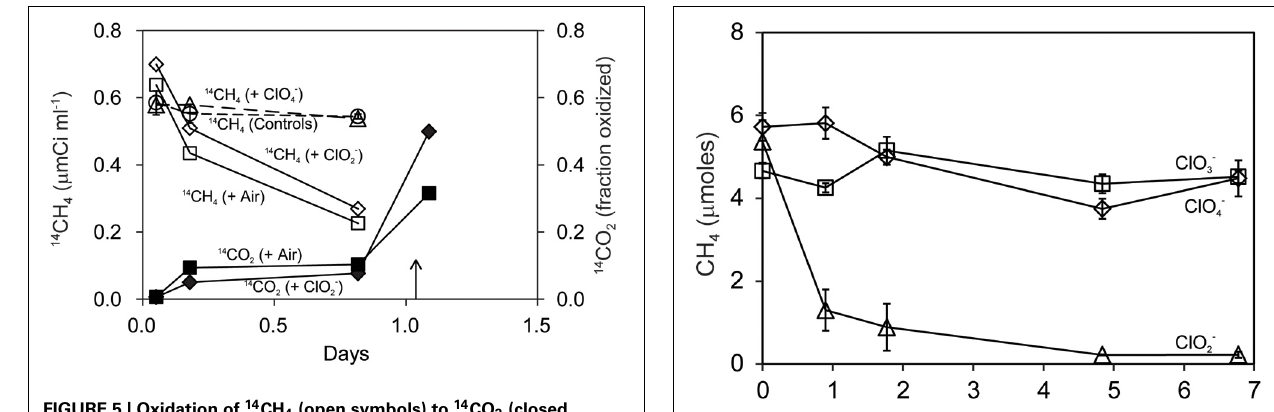
FIGURE 5 | Oxidation of 14 CH 4 (open symbols) to 14 CO 2 (closed symbols) by M. trichosporium OB3b during anaerobic incubations with D. agitata CKB following addition of ClO − 4 (triangles) and ClO − 2 (diamonds). Triangles represent the mean and standard deviation of triplicate measurements of samples with ClO − 4 added. All others were single bottles. Controls (no bacteria or no chloroxyanion added) were pooled and are shown as circles with error bars. Aerobic incubations with M. trichosporium OB3b alone are also shown (squares). Samples were acidified at the time indicated by the arrow.